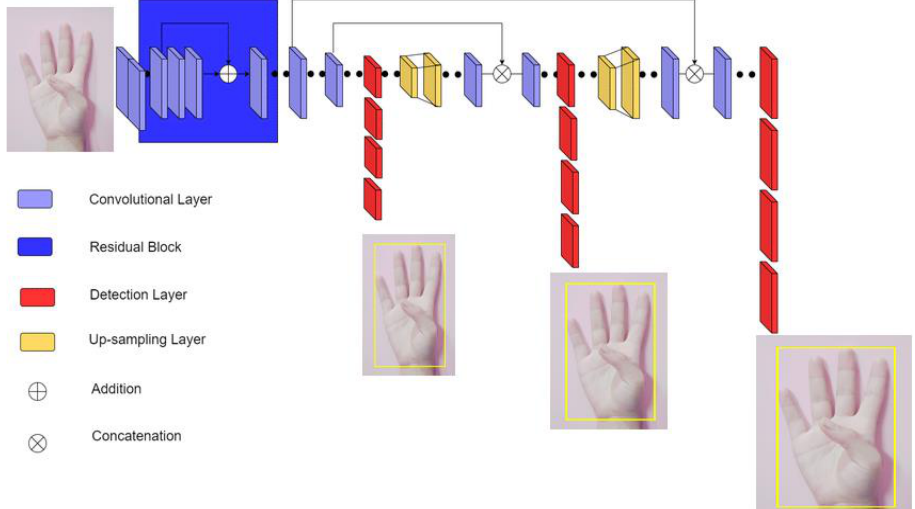
Figure 4. Architecture of the neural network for hand gesture recognition.